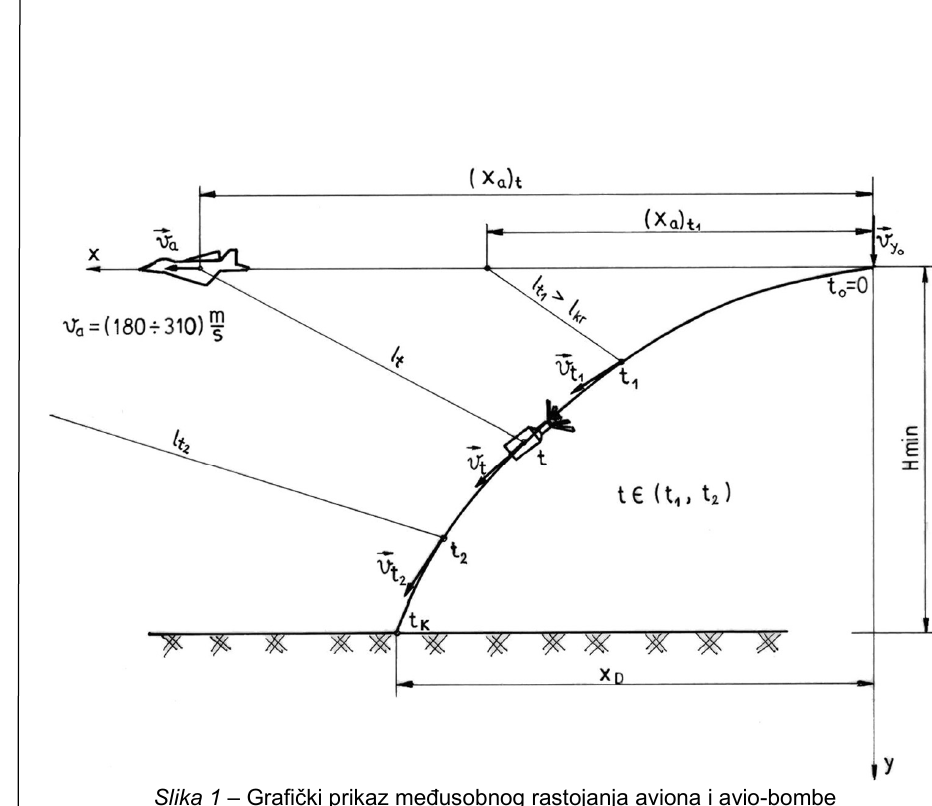
Figure 1 – Graphical illustration of a mutual position of an aircraft and an anti-armor